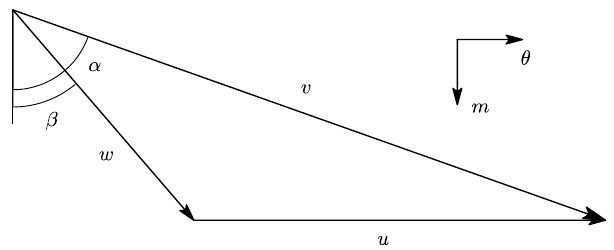
Figure 2. Velocity triangle showing the notation and conventions used in this